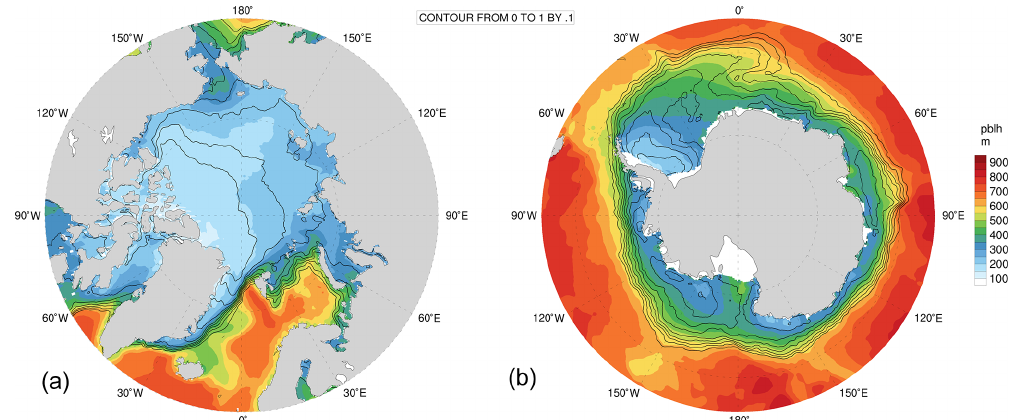
Figure 11. Yearly average of sea-ice cover (contours) and atmospheric boundary layer height (shaded) over the antarctic (b) and arctic (a)